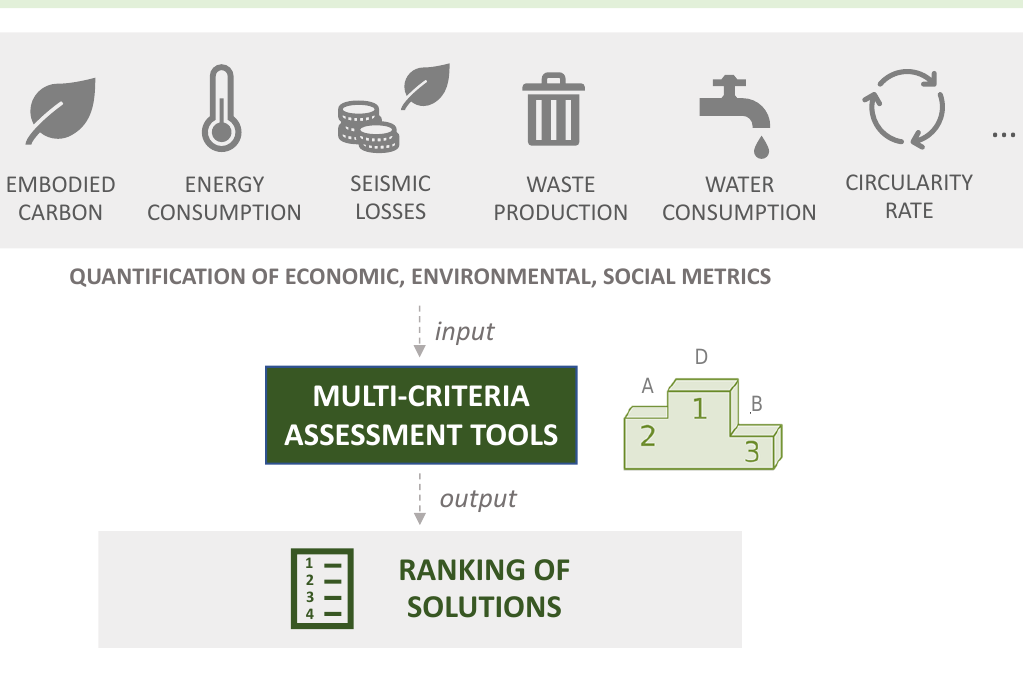
Figure 4. Workflow of the decision-making process for the selection of the best retrofitting option.